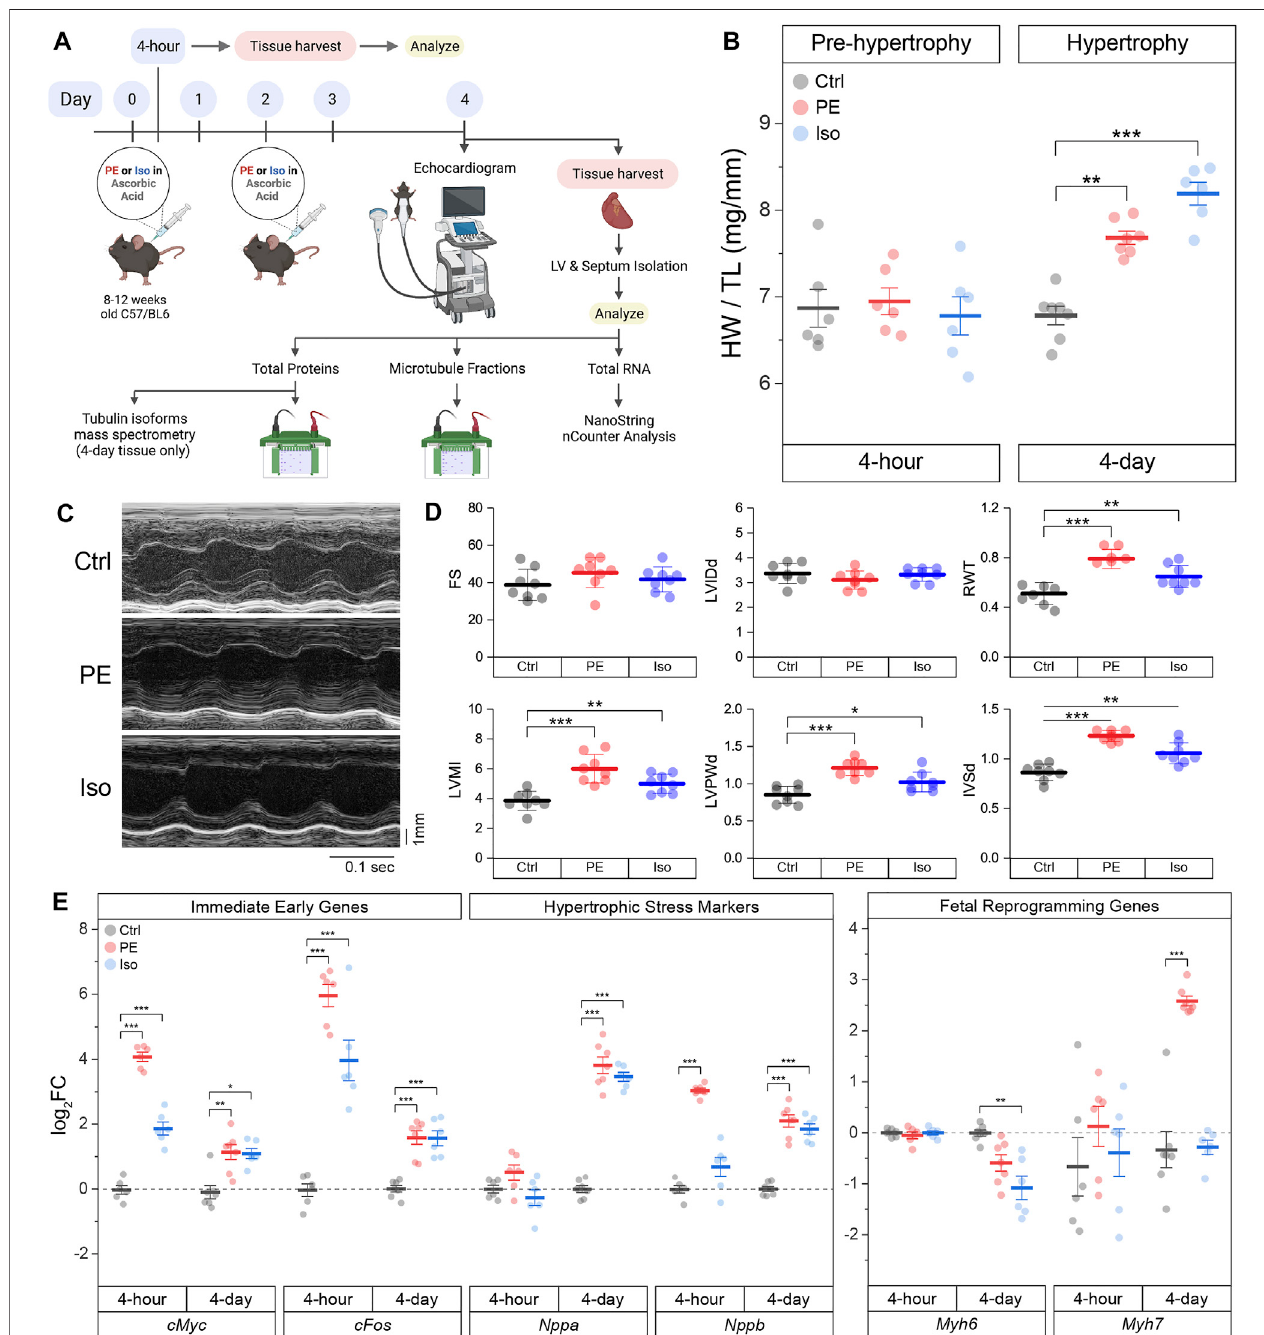
FIGURE 2 | Acute α - or β - adrenergic stimulation induces cardiac hypertrophy. (A) Graphical scheme of the experimental plan. (B) Heart-weight/Tibia length (HW/ TL) data of mice 4-h ( n = 6) or 4-days ( n = Ctrl:7, PE:7, Iso:6) following 10 mg/kg/injection of phenylephrine (PE) or 5 mg/kg/injection of isoproterenol (Iso). (C) Representative echocardiographic M-mode images of 4-days mice hearts. (D) Quanti fi cation of relevant echocardiographic parameters: FS = Fractional Shortening, LVIDd = Left-Ventricular Internal Diameter at end diastole, RWT = Relative Wall Thickness, LVMI = Left-Ventricular Mass Index, LVPWd = Left-Ventricular Posterior Wallthickness atenddiastole,IVSd=InterVentricular Septal thicknessat enddiastole ( n =8). (E) Relativelog 2 fold-changeofnCountermRNAcountsofImmediateEarly Genes (IEGs), hypertrophic stress markers, and genes of fetal reprogramming ( n = 4 h: 6, 4 days: Ctrl:7, PE:7, Iso:6). For all box plots, whiskers represent ± 1SEM and bolded-lines represent mean. For (B, D) , * represents p-value from Welch-corrected two-tailed two-sample student ’ s t-test < 0.025, ** represents p < 0.01, and *** represents p < 0.001. For (E) , * represents Bonferroni adjusted (for 45 genes) p-value < 0.025 (Bonferroni-corrected for two comparisons), ** represents adj_ p < 0.01, and *** represents adj_ p < 0.001 (see Methods for more statistical details).